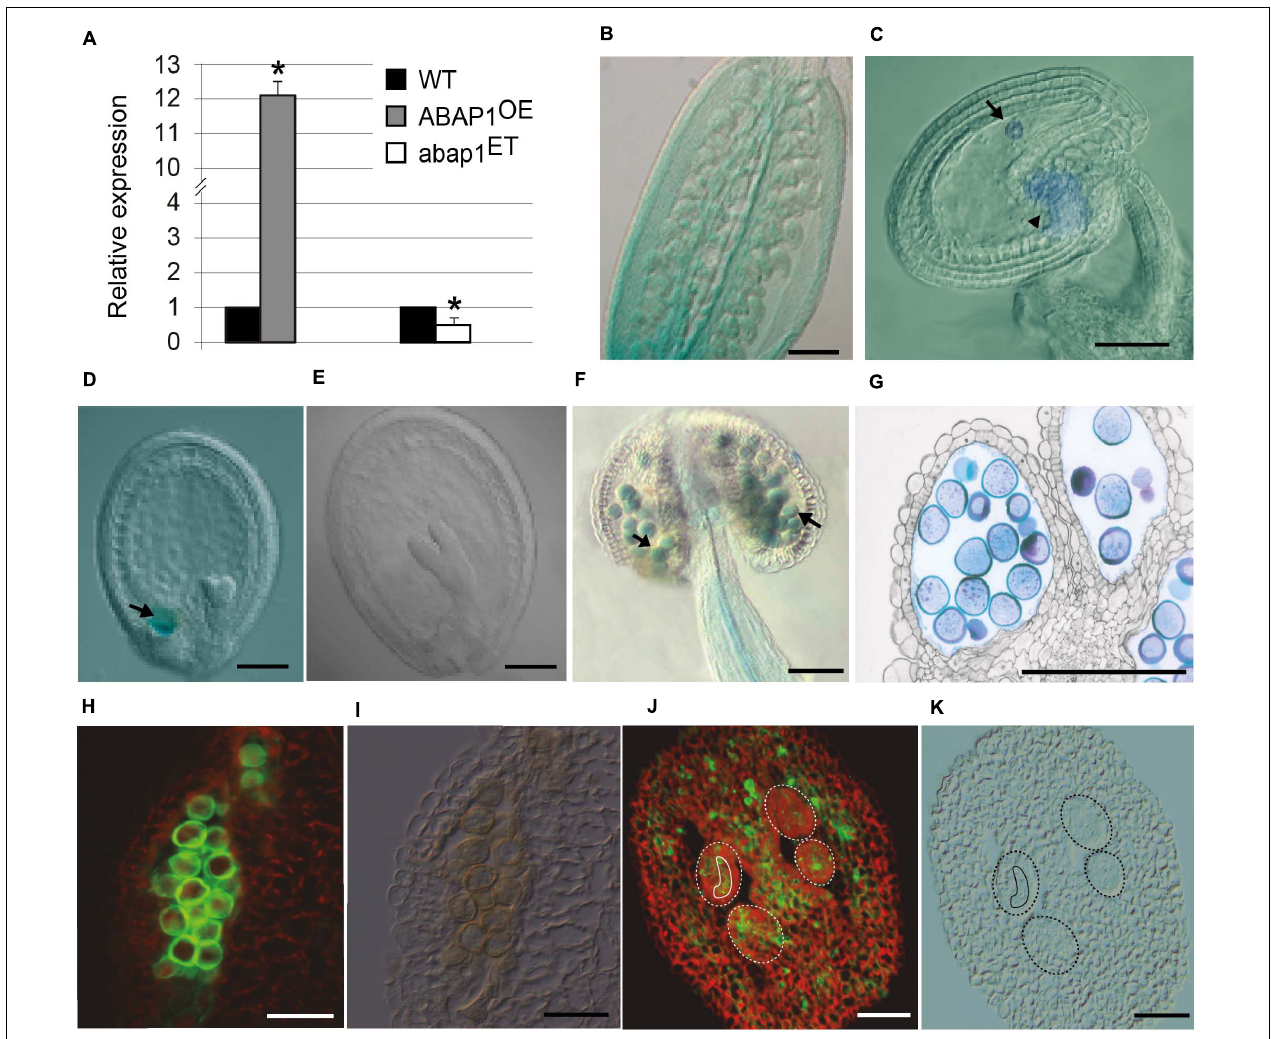
FIGURE 2 | ABAP1 expression in flowers. (A) Relative mRNA levels of ABAP1 were determined by qRT-PCR in wild-type, ABAP1 OE and abap1 ET flowers. Data were normalized with UBQ14 as reference gene and were compared with wild-type. Data shown represent mean values obtained from independent amplification reactions ( n = 3) and biological replicates ( n = 2). Each biological replicate was performed with a pool of 15 inflorescences. Bars indicate mean ± standard error of biological replicates. A statistical analysis was performed by t -test ( p -value < 0.05). Asterisks (*) indicate significant changes. (B–G) Nomarski microscopy of cleared tissues. (B) promABAP1:GUS activity in the ovary prior to fertilization. (C) promABAP1:GUS activity early after fertilization. Arrow and arrowhead point to embryo and chalaza expression, respectively. (D) Decrease in GUS activity in embryos of 72 h (heart stage). The expression in the chalazal chamber, however, remains (arrow). (E) In torpedo stage, GUS activity is not seen neither in the embryo or chalaza. (F) promABAP1:GUS activity in anthers. Arrow points to GUS activity in pollen. (G) Cross section of anthers with promABAP1:GUS activity in pollen. (H,J) Localization of ABAP1 protein by epifluorescence of reproductive tissues using anti-ABAP1 antibodies conjugated with Alexa Fluor 488 and (I,K) corresponding DIC microscopy. (H,I) ABAP1 protein localization in a pollen sac cross section. (J,K) ABAP1 protein localization in cross section of ovary and ovules. Dashed lines indicate the perimeter of ovules and the full line is around the embryo sac. The scale bars correspond to 100 µ m in (B) , 20 µ m in (C–G) , and to 10 µ m in (H–K)